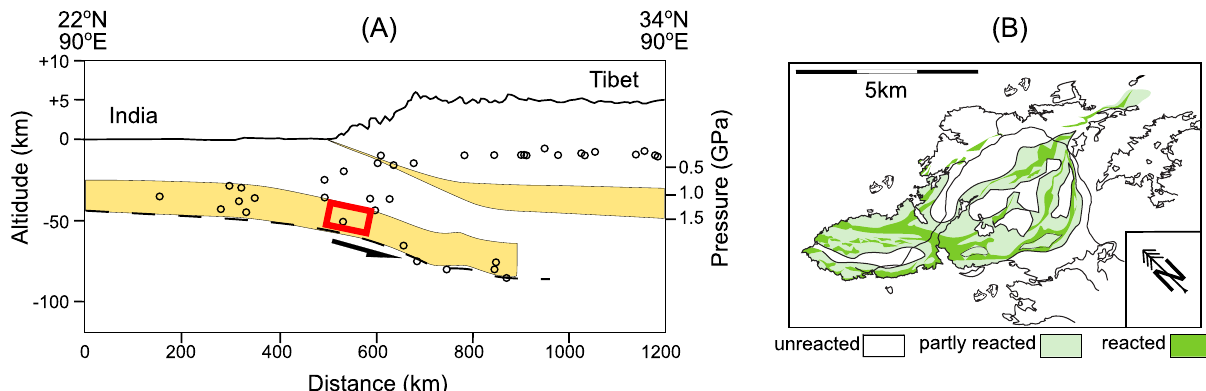
Fig. 1 Geophysical and fi eld constraints on orogenic lower crust. Characteristics of lower crust during continent collision. A Distribution of earthquakes during the India-Asia collision exempli fi ed by a cross-section along 90°E. Lower crust denoted by yellow color (modi fi ed from Jackson et al. 15 ). Lithostatic pressures are given along the right vertical axis. The red rectangle indicates the Indian lower crust that experiences a lithostatic pressure of ca. 1.5 GPa. B Spatial distribution of reacted and unreacted rock volumes on the island of Holsnøy, Norway. The reacted zones correspond to highly deformed regions where the mineral assemblages suggest metamorphic pressures in the range 1 – 2 GPa (image modi fi ed from Austrheim, 2013 1 , with permission from